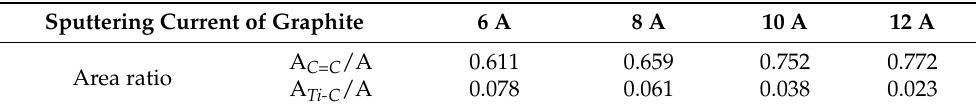
Figure 2. Gaussian fitting of C1s of the films prepared at various sputtering currents of graphite. Table 1. The Ratios of C=C and C–Ti Bonds as Function of Sputtering Current of Graphite for Prepared Multilayered Films.